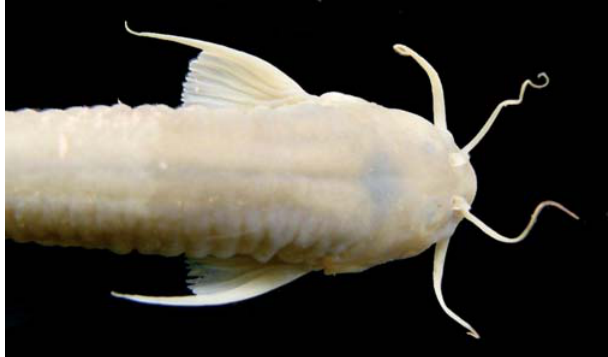
Fig. 3. Trichomycterus uisae , holotype, CAC-CDMB 72, 54 mm SL. Cueva El Misterio, upper Sogamoso River basin, Santander, Colombia. Dorsal view of head.